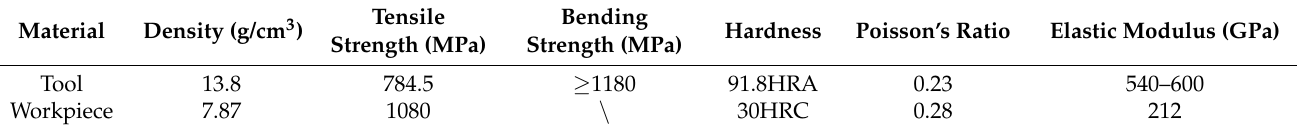
Table 2. Property parameters of tool and workpiece materials.